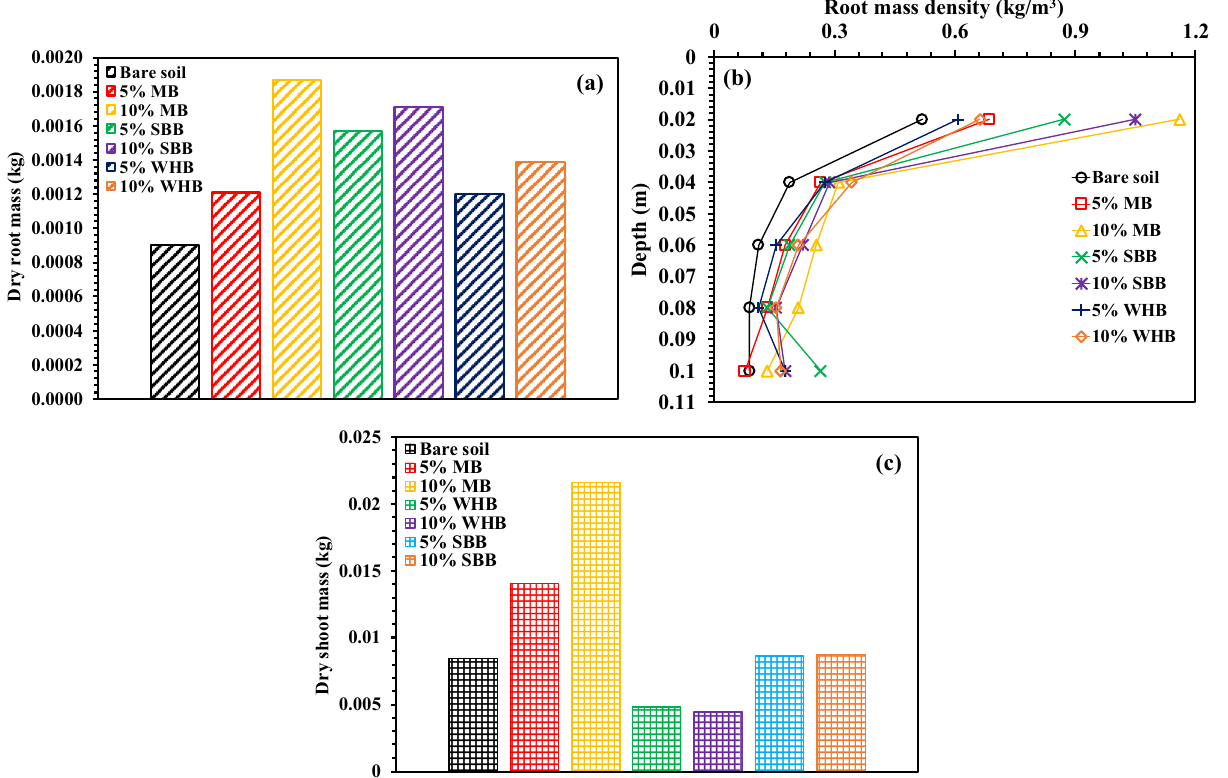
Figure 8. Variation of ( a ) dry root mass, ( b ) root mass density and ( c ) dry shoot mass in different